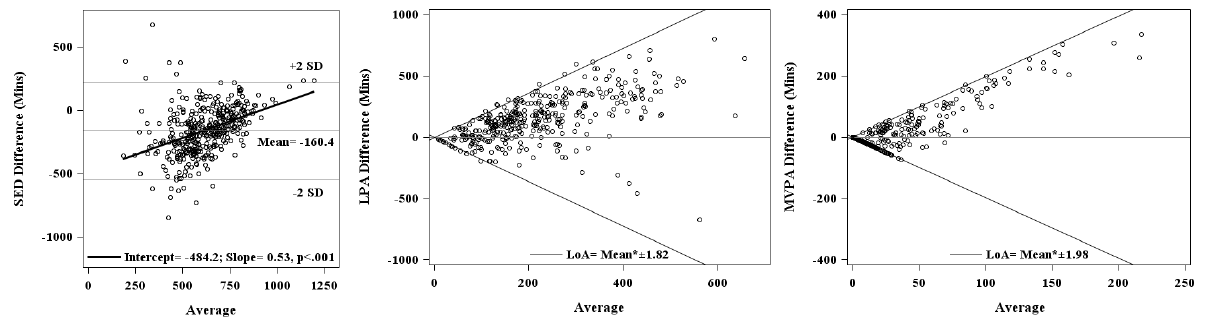
Figure 4. Bland-Altman plot of the BeWell24 app versus activPAL3c. (A) Total time spent sedentary (minutes/day); (B) total time spent in LPAs (minutes/day); (C) total time spent in MVPAs (minutes/day). The y-axes are the difference between the two measures (BeWell24 app – activPAL3c), and the x-axes are the average between the two measures ([BeWell24 app + activPAL3c]/2). SED: sedentary activity; LPA: light-intensity physical activity; MVPA: moderate-vigorous physical activity; LoA: Limits of agreement for heteroscedastic data (calculated as a function of the mean,